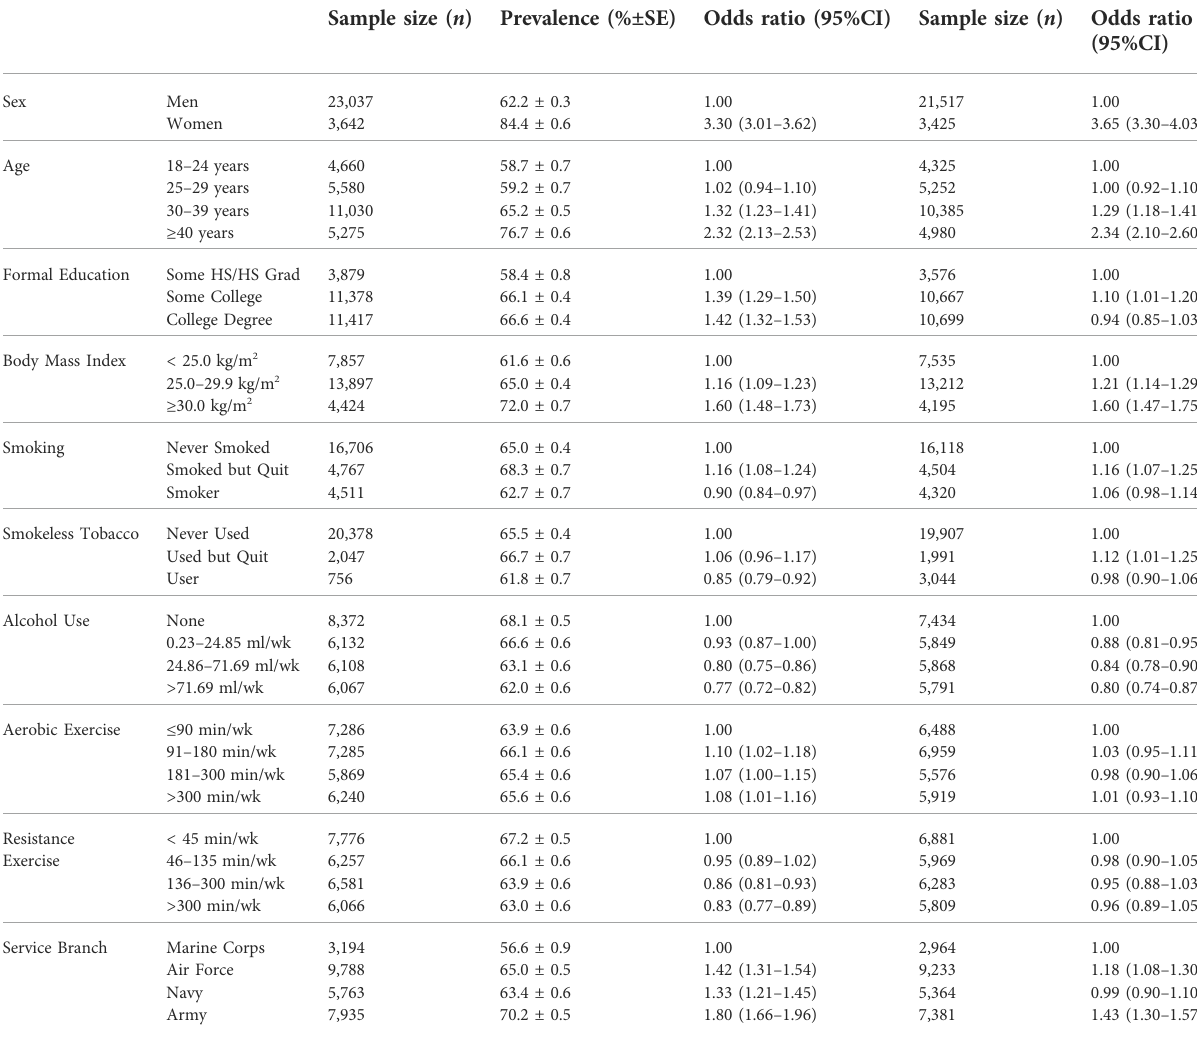
TABLE 4 Association between fi lled prescription medications and demographic and lifestyle factors. Variable